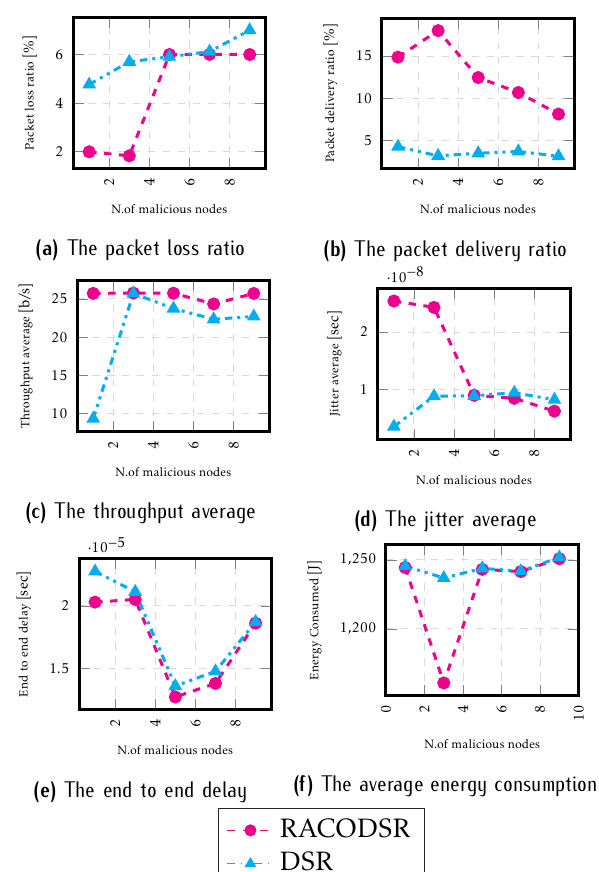
Figure 8: The QoS evaluation in di ff erent